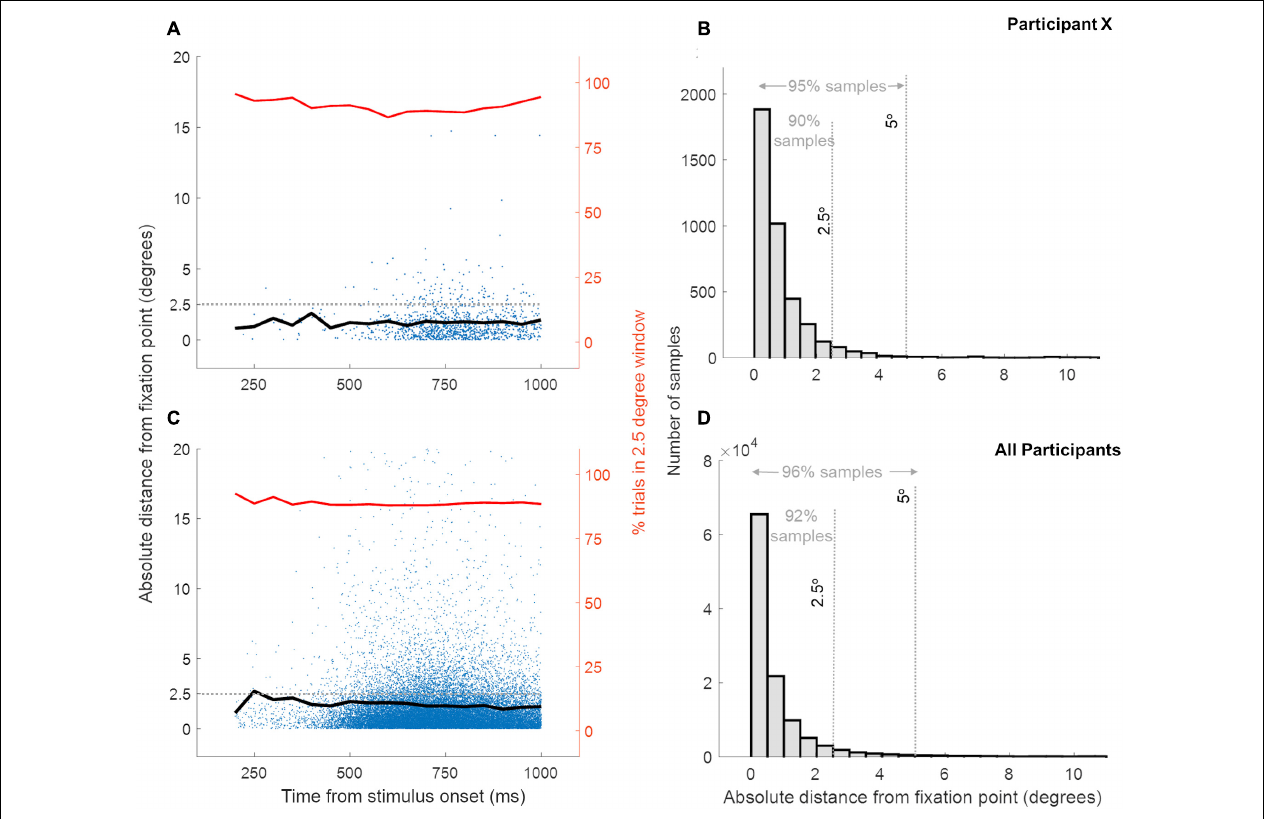
FIGURE 2 | Distance of eye gaze location from the fixation point at the instance of response across trials. Panels (A,B) show the data for a single representative participant while panels (C,D) show data for all 27 participants, for both multisensory tasks. Each blue dot in panels (A,C) represents the eye gaze distance from fixation for a single trial while the black line shows the mean eye gaze distance from fixation over trials. The red line indicates the percentage of trials, at the response time, where the eye gaze location was within 2.5 ◦ distance from the fixation point. Panels C and D show the distribution of eye gaze distance from fixation and confirm that eye gaze position was within a few degrees from the fixation point for a high percentage of